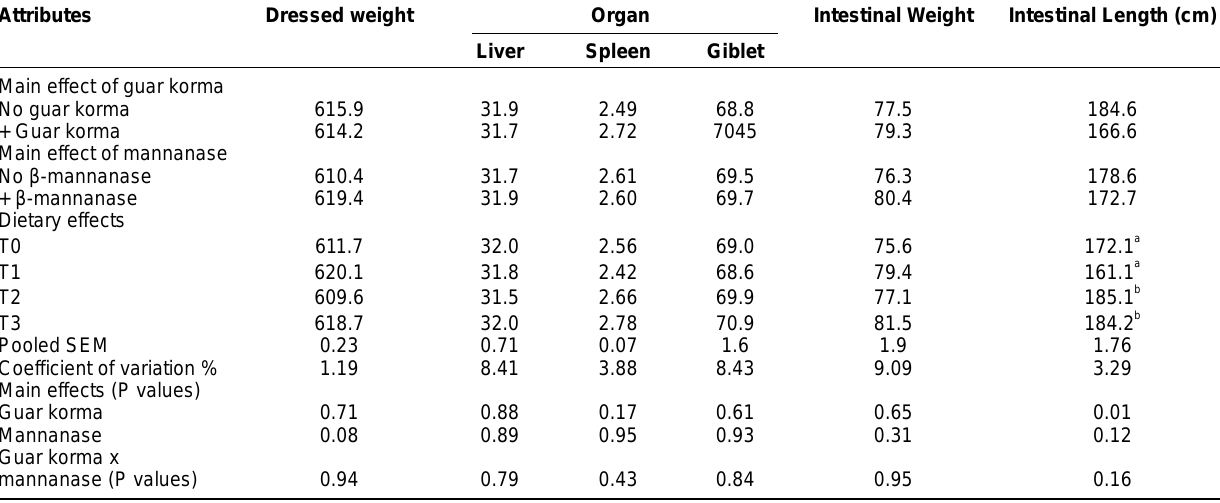
Table-3. Effect of guar korma and β-mannanase on carcass traits (in g/kg unless stated otherwise).